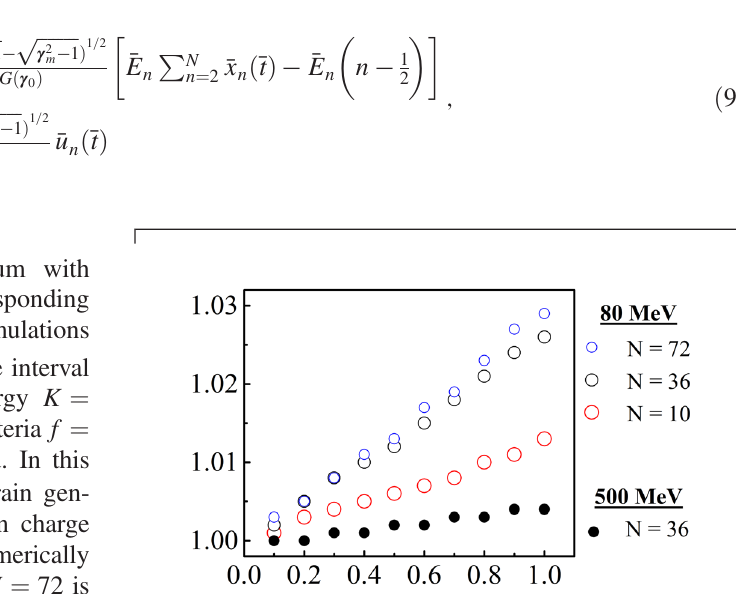
(in terms of Δ ) as a function of f t